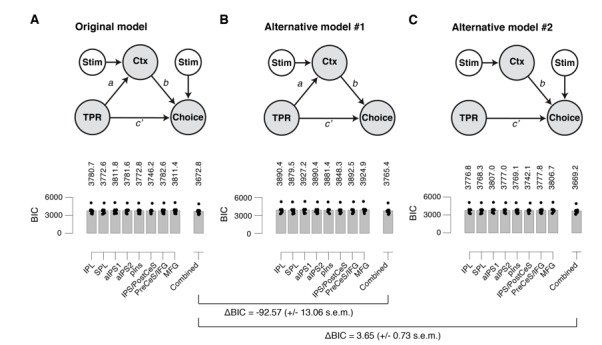
(A) Left: Schematic of original mediation analysis. Ctx, choice-specific cortical response; stim, stimulus (signal+noise vs. noise). All arrows are regressions.Right: BIC values for different choice-specific cortical responses (independently used as the Ctx node). (B) same as panel A, but for alternative model #1 (without stimulus input into Choice). (C) same as panel A, but for alternative model #2 (that does not allow for the indirect path – that is, a model lacking the path from TPR to Ctx).